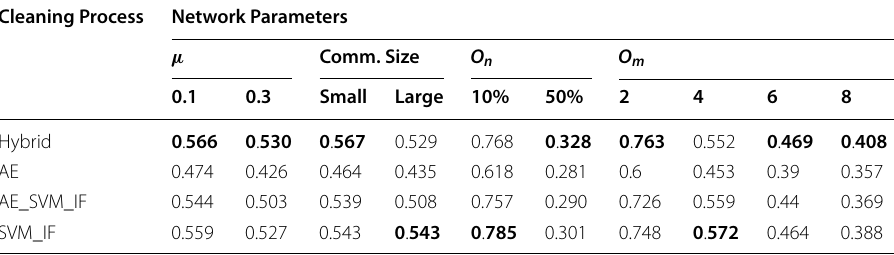
Table 11 Average NMI scores of AC-SLPA achieved using different cleaning processes on large synthetic networks with different network parameters Cleaning